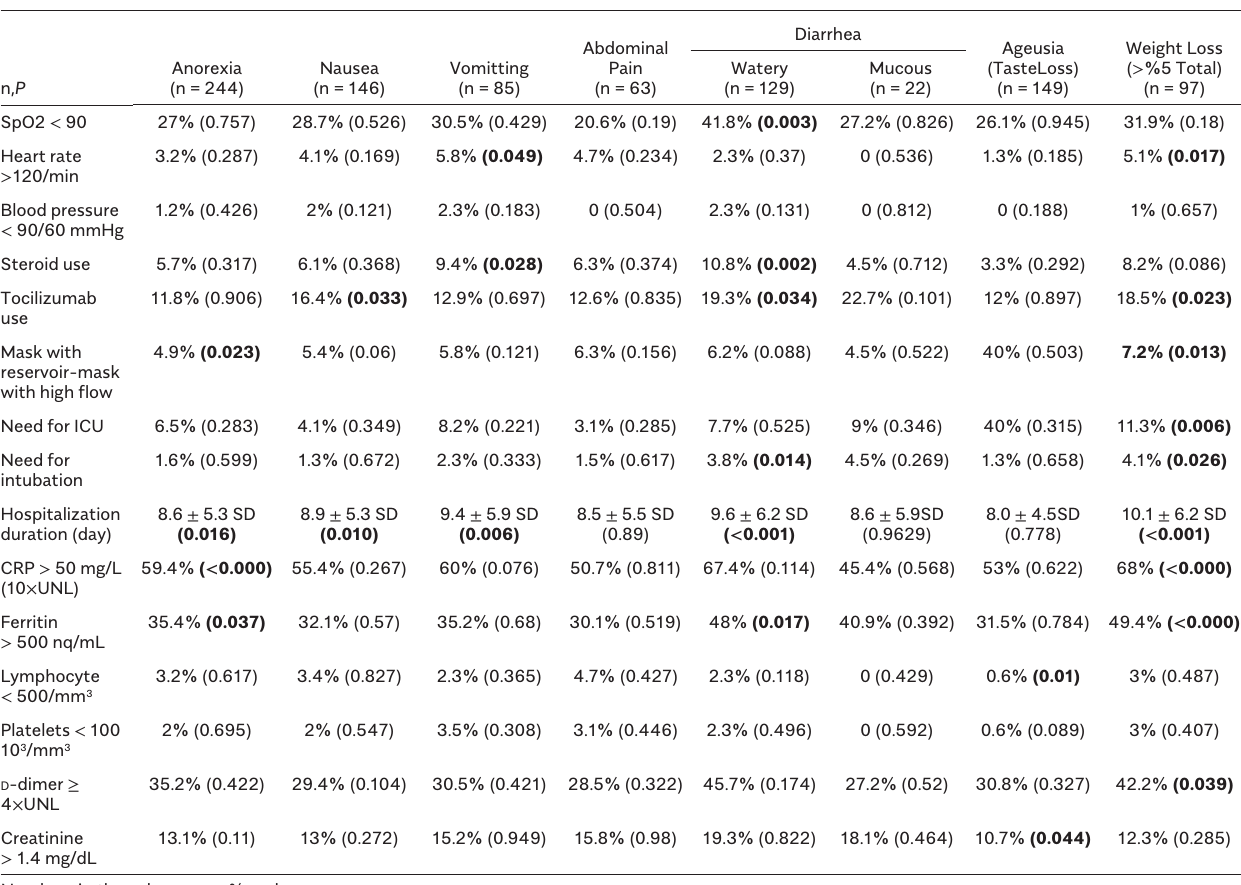
Numbers in the columns are % and p. SpO2, oxygen saturation; CRP, C-reactive protein; ICU, intensive care unit; GI, gastrointestinal. P <0.05 were bold